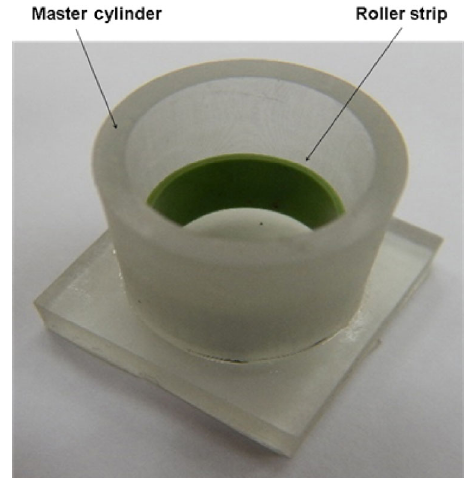
Fig. 2 Illustration of cast process to obtain plunger shape using textured strips.